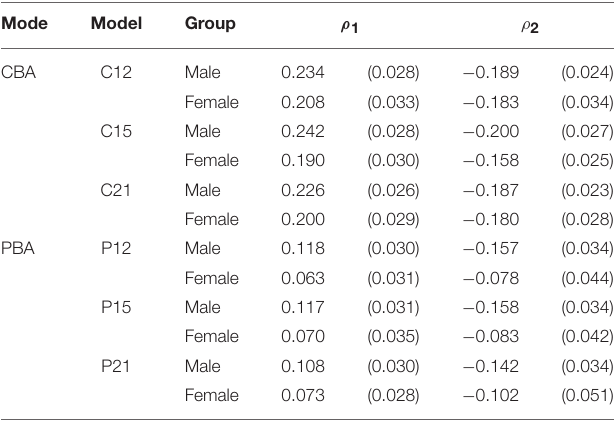
TABLE 3 | Estimated parameters of the cross-relation function for the B-GLIRT interaction model. Mode